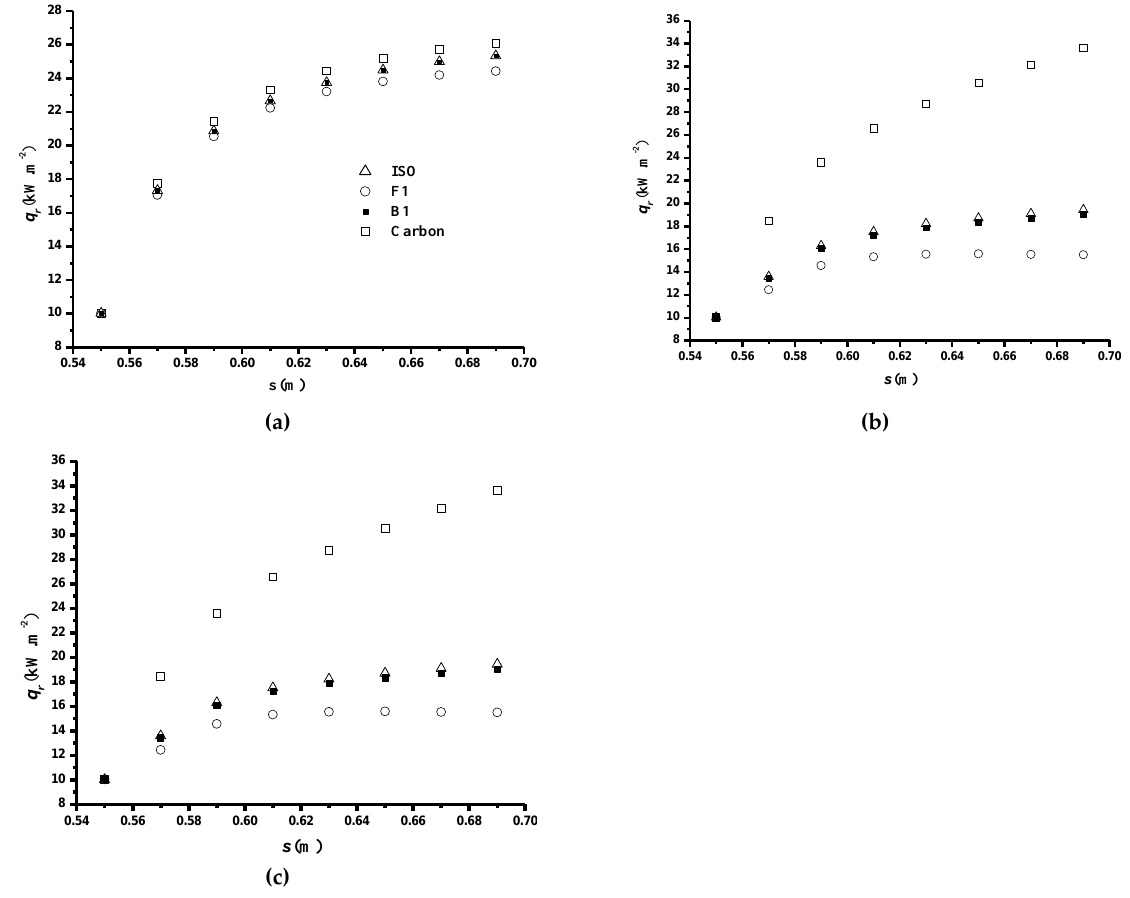
Table 4. Complex refractive index for different coals and ashes in-near infrared region. Coal and Ash Carbon Anthracite Bituminous Lignite Ash Particle size parameter 𝑥 𝑝 1 1 1 1